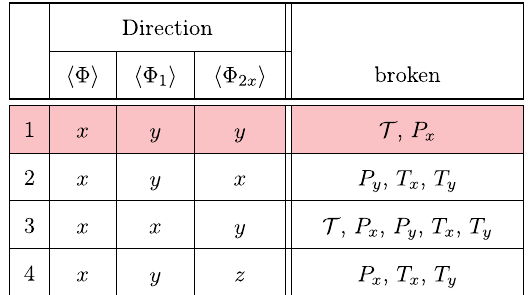
when h Φ 1 i ∥ h Φ 2 i . This situation is further distinguished by i breaking the fewest symmetries. We refer to this phase as C and later equate it and the bosonic phase C f